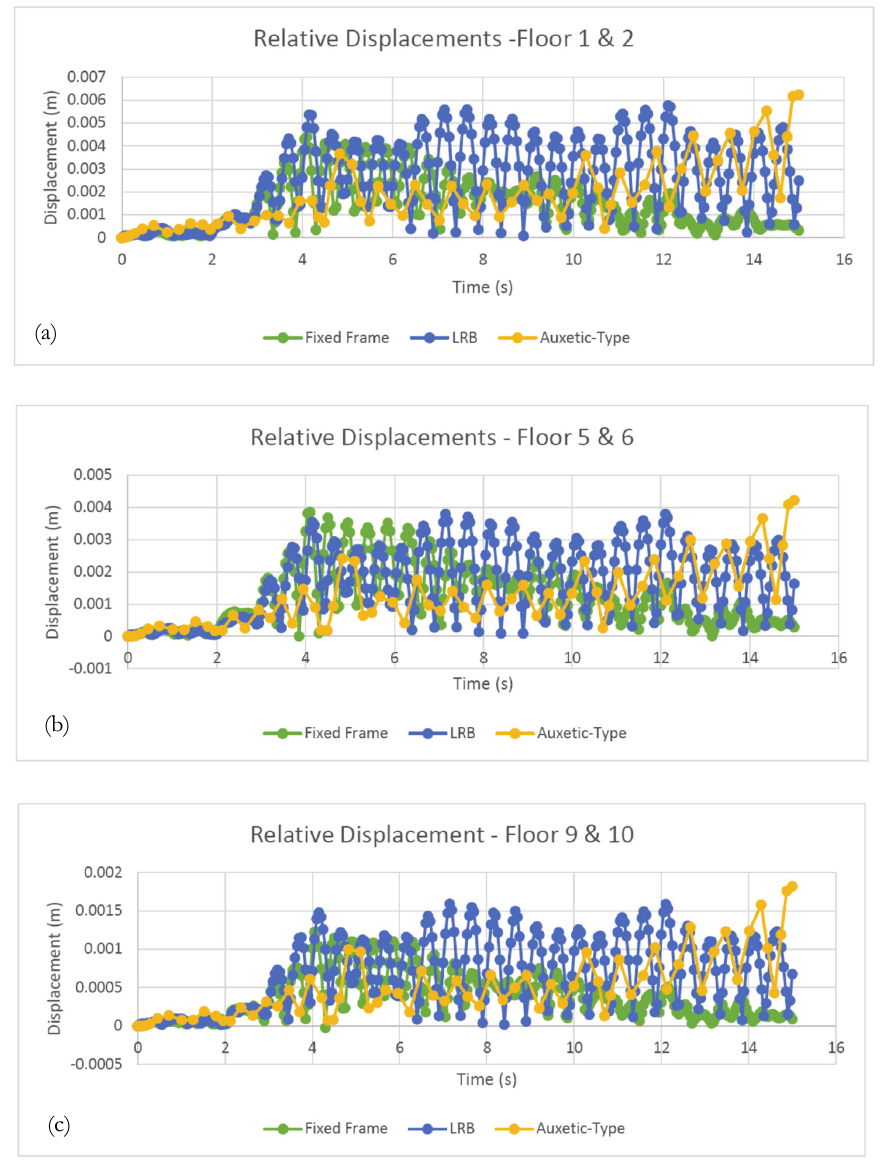
Figure 15: Relative displacement of floors (a) 1 and 2, (b) 5 and 6, (c) 9 and